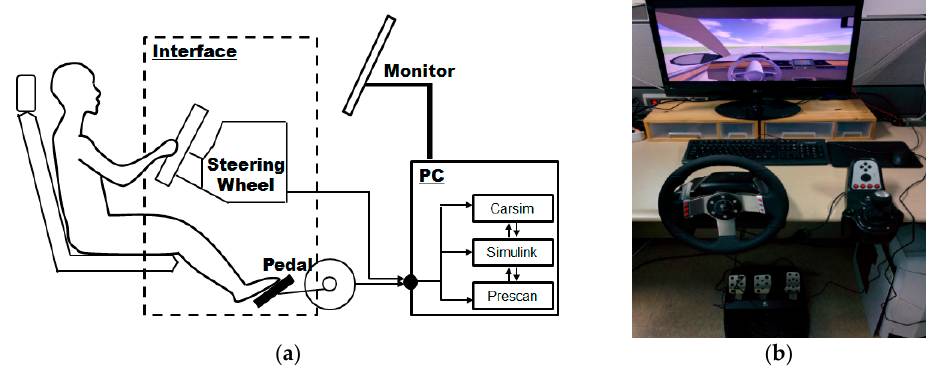
Figure 8. Setup for driving simulator experiments: ( a ) schematic diagram of driving simulator; and ( b ) setup of Steering wheel and pedal for obtaining driving